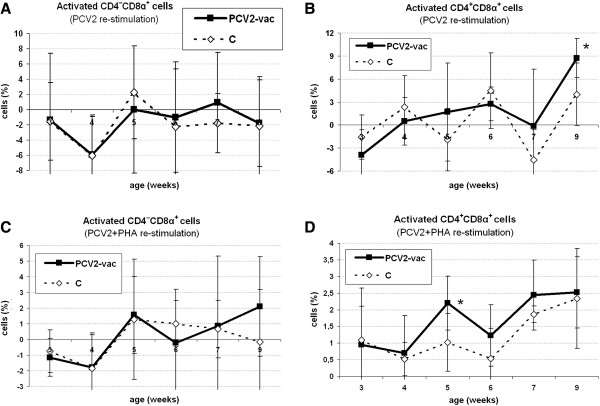
Cellular immune reactivity of activated T lymphocyte subsets upon in vitro stimulation after Cap protein PCV2 vaccination. Levels of CD4–CD8α+ cytotoxic and CD4+CD8α+low memory T helper cells in the lymphoblast fraction of PCV2-vaccinated (PCV2-vac) and control (C) pigs upon 48-h PCV2b (A, B) and PCV2b + PHA (C, D) in vitro stimulation during the post-vaccination (PV) period. PCV2-vac pigs were vaccinated at 3 weeks of age using a PCV2a Cap protein-based subunit vaccine. Values are normalized to the corresponding medium (PCV2 stimulation) or PHA-alone (PCV2 + PHA stimulation) control samples, respectively. (*): statistically significant difference between groups (p < 0.05).